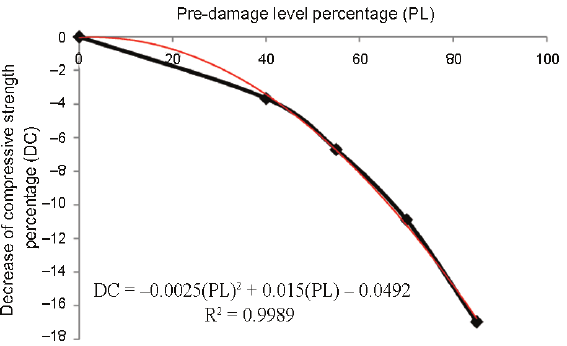
Fig. 7. Relationship between pre-damage level and decrease of compressive